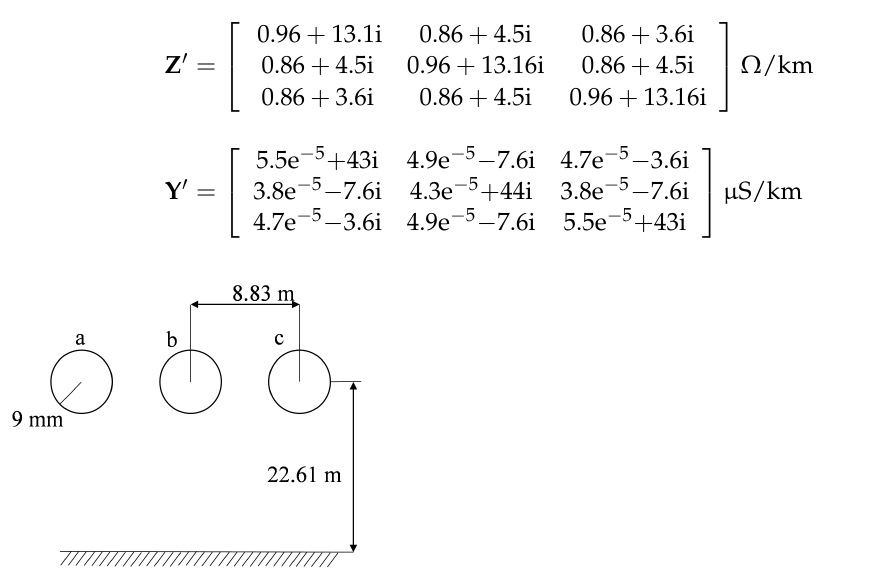
Figure 12. Cross-section representation of three-phase transmission line.